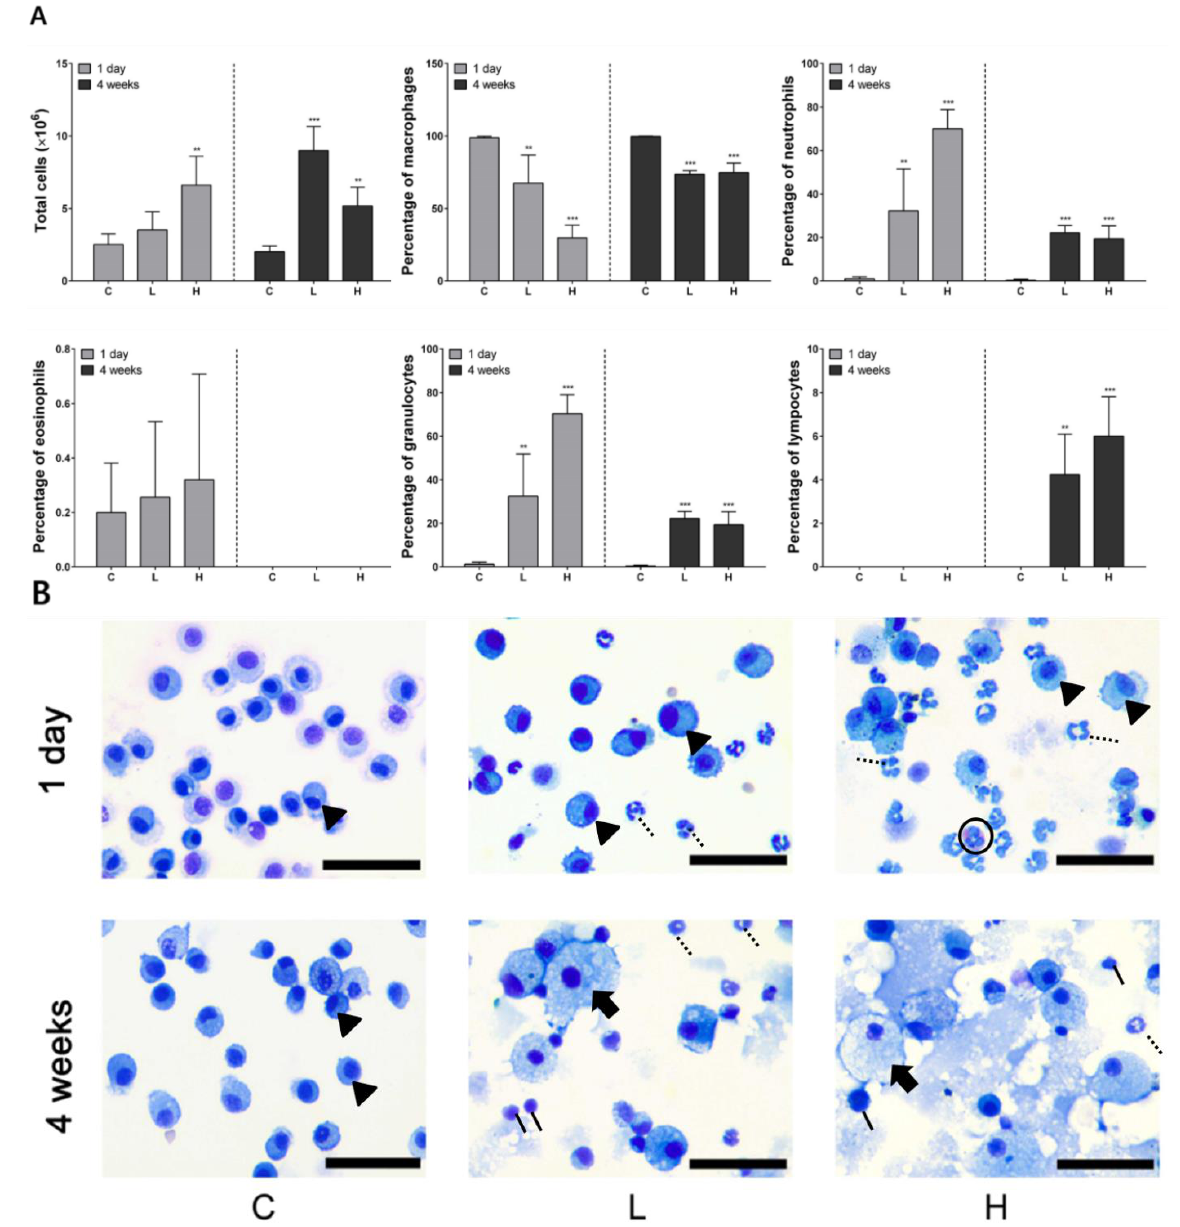
Figure 2. Cytological analysis of bronchoalveolar lavage fluid (BALF) after intratracheal instillation of nickel oxide nanoparticles (NiO NPs). The number of total cells, percentage of macrophages, neutrophils, eosinophils, granulocytes, and lymphocytes is indicated ( A ). Diff–Quik staining images of immune cells in BALF after intratracheal instillation of NiO NPs. Macrophages (arrowhead) were observed after 1 day in C, L, and H. However, foamy macrophages (arrow) were observed only at 4 weeks in the L and H ( B ). Although neutrophils (dotted line) were recruited in the BALF of L and H, lymphocytes (solid line) were recruited at 4 weeks after instillation in BALF of L and H. Eosinophils (circle) were then observed 1 day after instillation in H from the cell image. Data are presented as mean ± standard deviation (SD) of each group. One-way analysis of variance (ANOVA) was performed for the comparison between the NiO NPs-treated and control groups with statistical significance indicated by ** p < 0.01 and *** p < 0.001. C: control group; L: low-dose group (50 cm 2 /rat); H: high-dose group (150 cm 2 /rat).